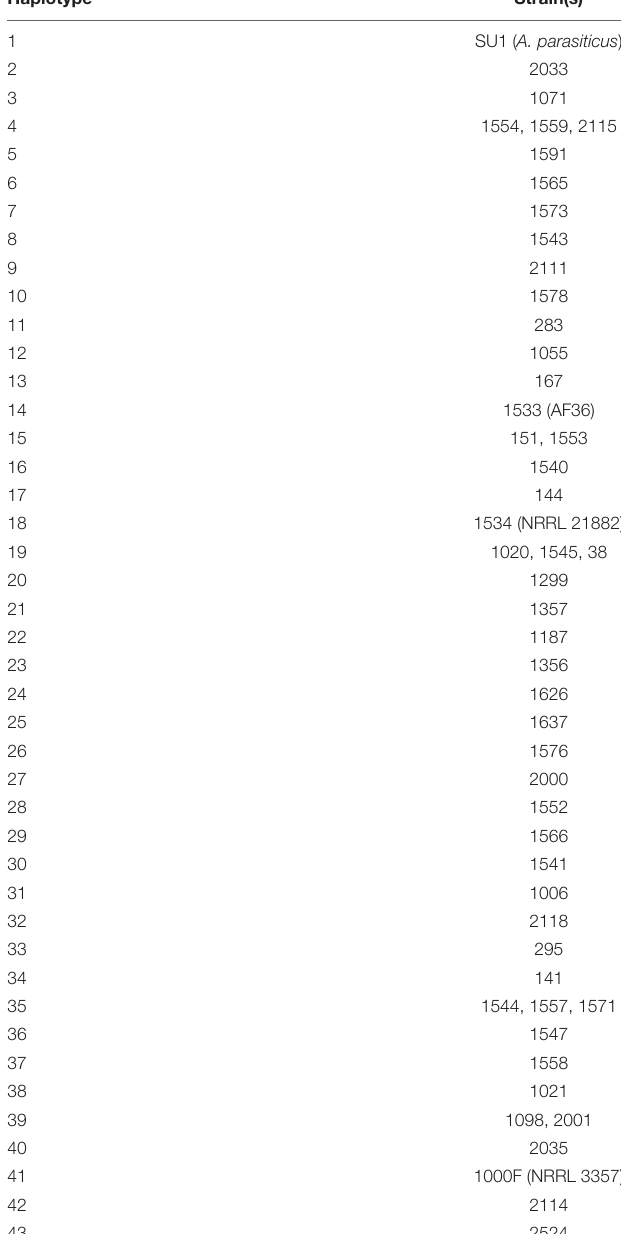
TABLE 2 | Haplotype identities for 51 Aspergillus strains examined in this study. Haplotype